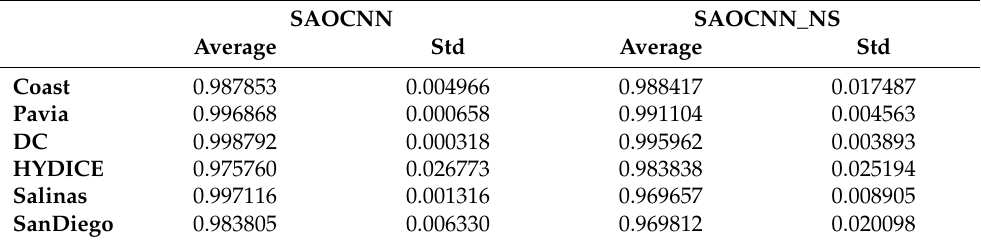
Table 3. AUC f of SAOCNN and SAOCNN_NS in repeated experiments. SAOCNN